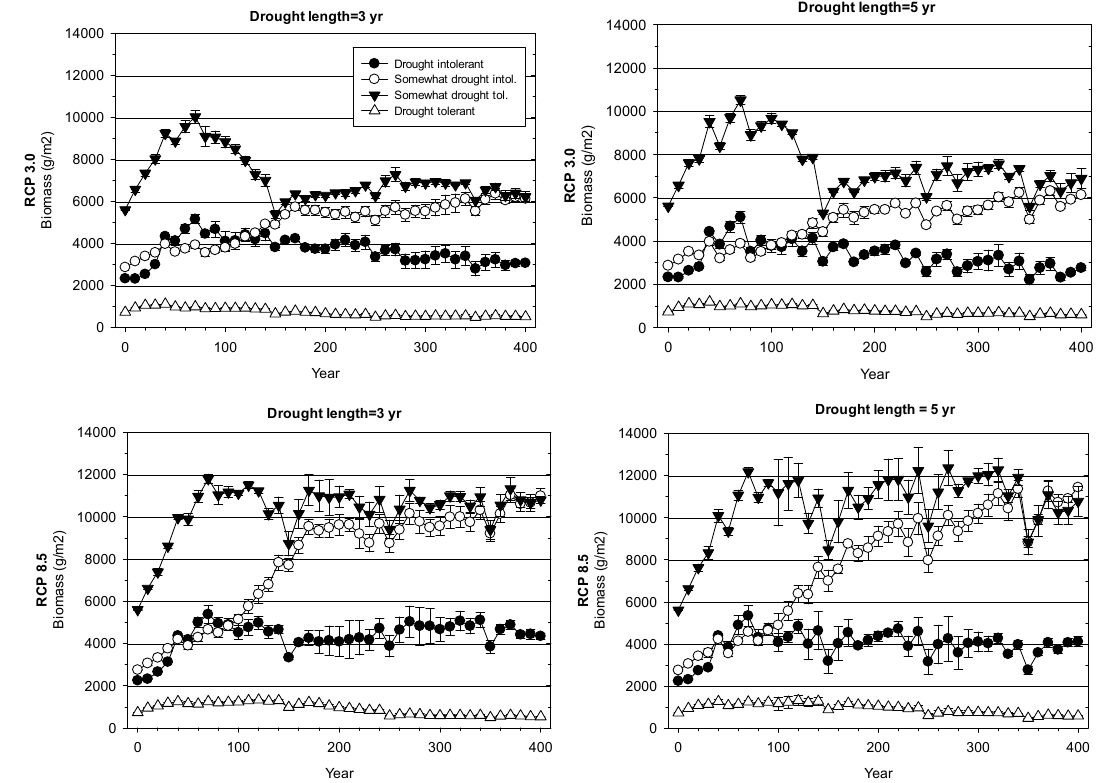
Figure 5. The effect of climate ( rows ) and drought length ( columns ) on productivity (mean species biomass) by drought tolerance groups. Error bars show one standard deviation.